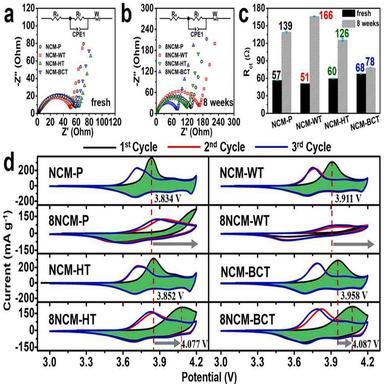
(a-b) Nyquist plots of NCM811 cathodes materials before/after air exposure for 8 weeks. The insets are the equivalent circuits. (c) EIS fitting results of Rct variations. (d) CV curves of fresh and stored materials for initial three cycles.